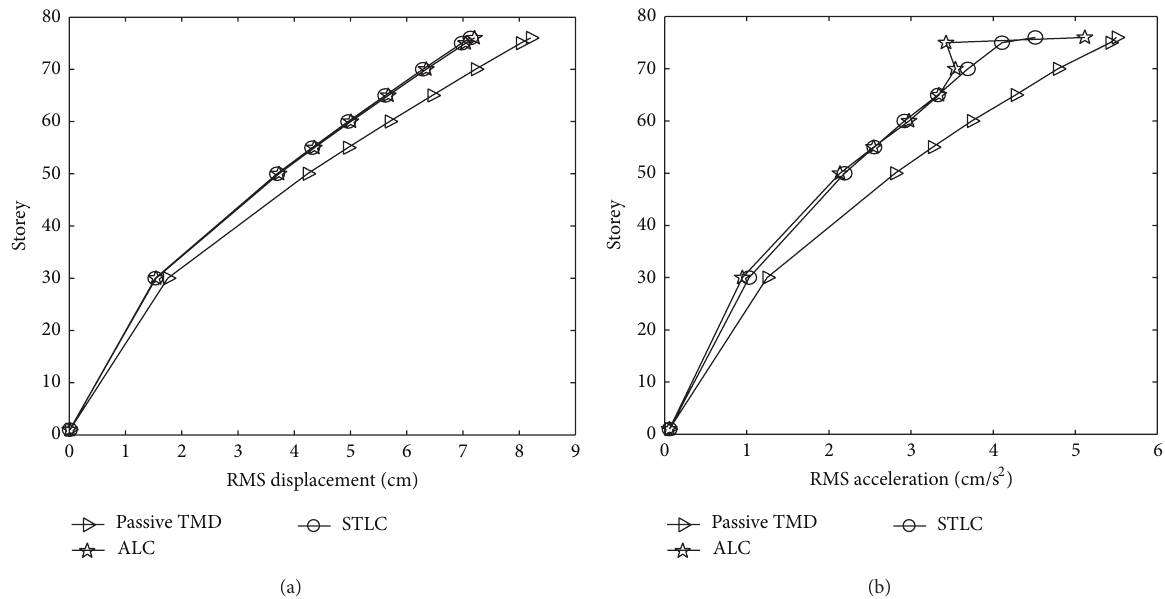
Figure 12: Comparison of RMS displacement and RMS acceleration ( −15 % stiffness